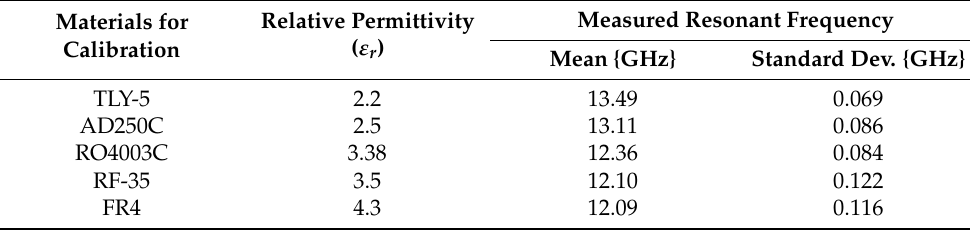
Table 3. Measurement results for the calibration